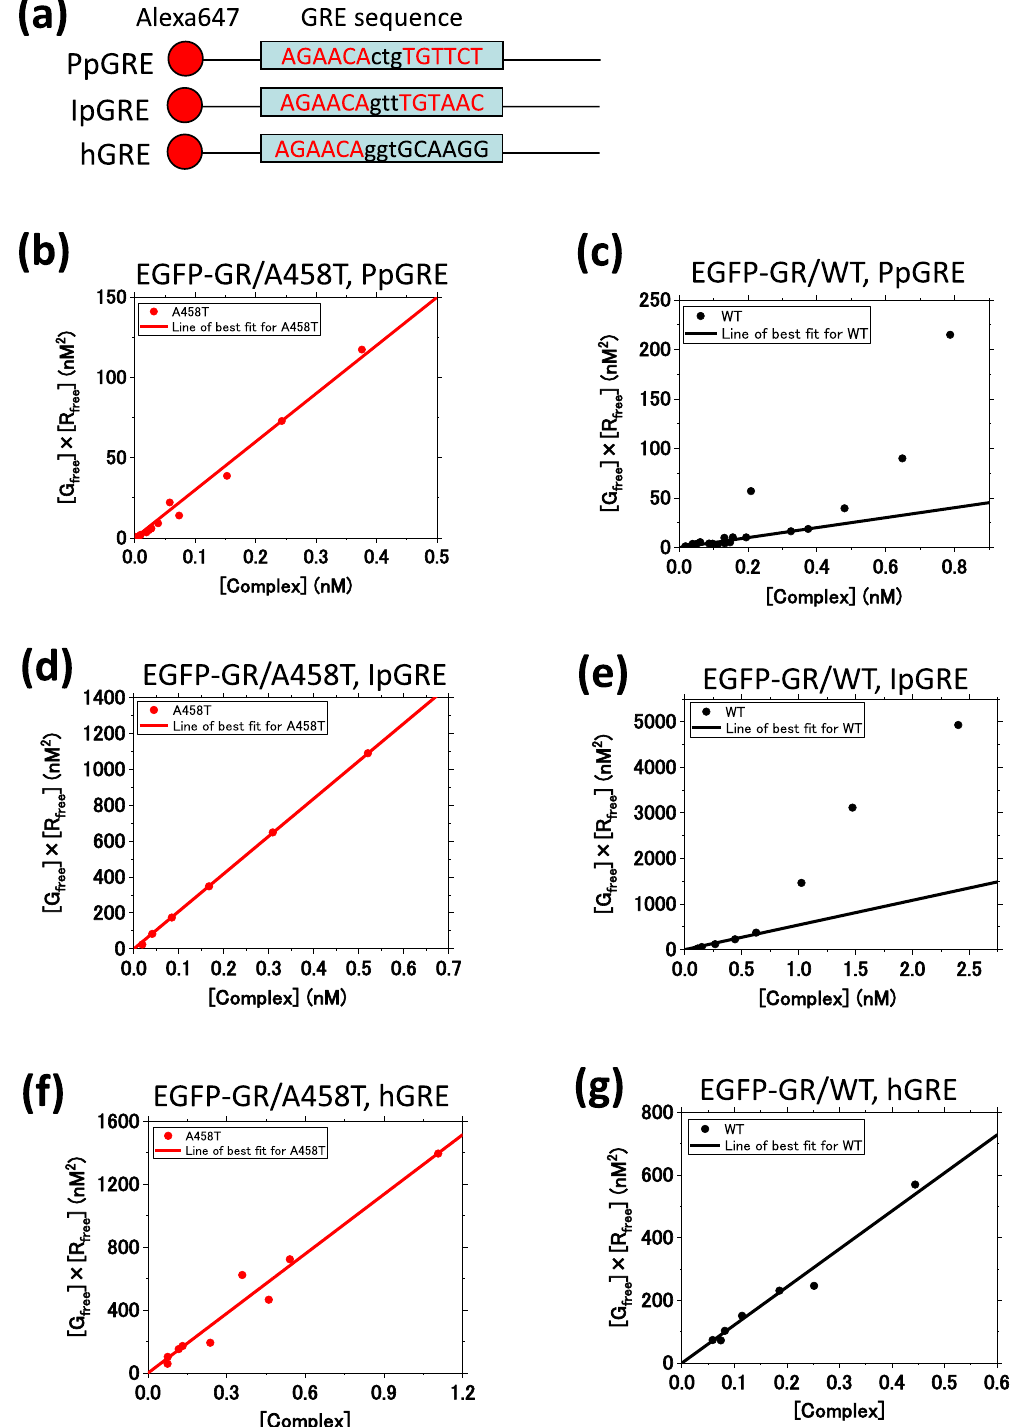
Figure 5. In vitro GR-DNA binding analysis using FCCS. ( a ) A schematic diagram of sequences of Alexa647- labeled GREs. PpGRE, IpGRE and hGRE denote perfect palindrome GRE (AGAACActgTGTTCT), imperfect palindrome GRE (AGAACAgttTGTAAC) and half GRE (AGAACAggtGCAAGG), respectively. IpGRE and hGRE were originated from the sequences in MMTV. ( b and c ) K d,DNA,app determination for the interaction of EGFP-GRs and Alexa647-PpGRE, by a linear least squares fitting. (b) EGFP-GR/A458T (N = 14, K d,DNA,app : 300 ± 10 nM), (c) EGFP-GR/WT (N = 23, K d,DNA,app : 50 ± 3 nM). ( d and e ) K d,DNA,app determination for the interaction of EGFP-GRs and Alexa647-IpGRE, by a linear least squares fitting. (d) EGFP-GR/A458T (N = 6, K d,DNA,app : 2100 ± 10 nM), (e) EGFP-GR/WT (N = 8, K d,DNA,app : 540 ± 40 nM). ( f and g ) K d,DNA,app determination for the interaction of EGFP-GRs and Alexa647-hGRE, by a linear least squares fitting. (f) EGFP-GR/A458T (N = 9, K d,DNA,app : 1260 ± 60 nM), (g) EGFP-GR/WT (N = 7, K d,DNA,app : 1210 ± 50